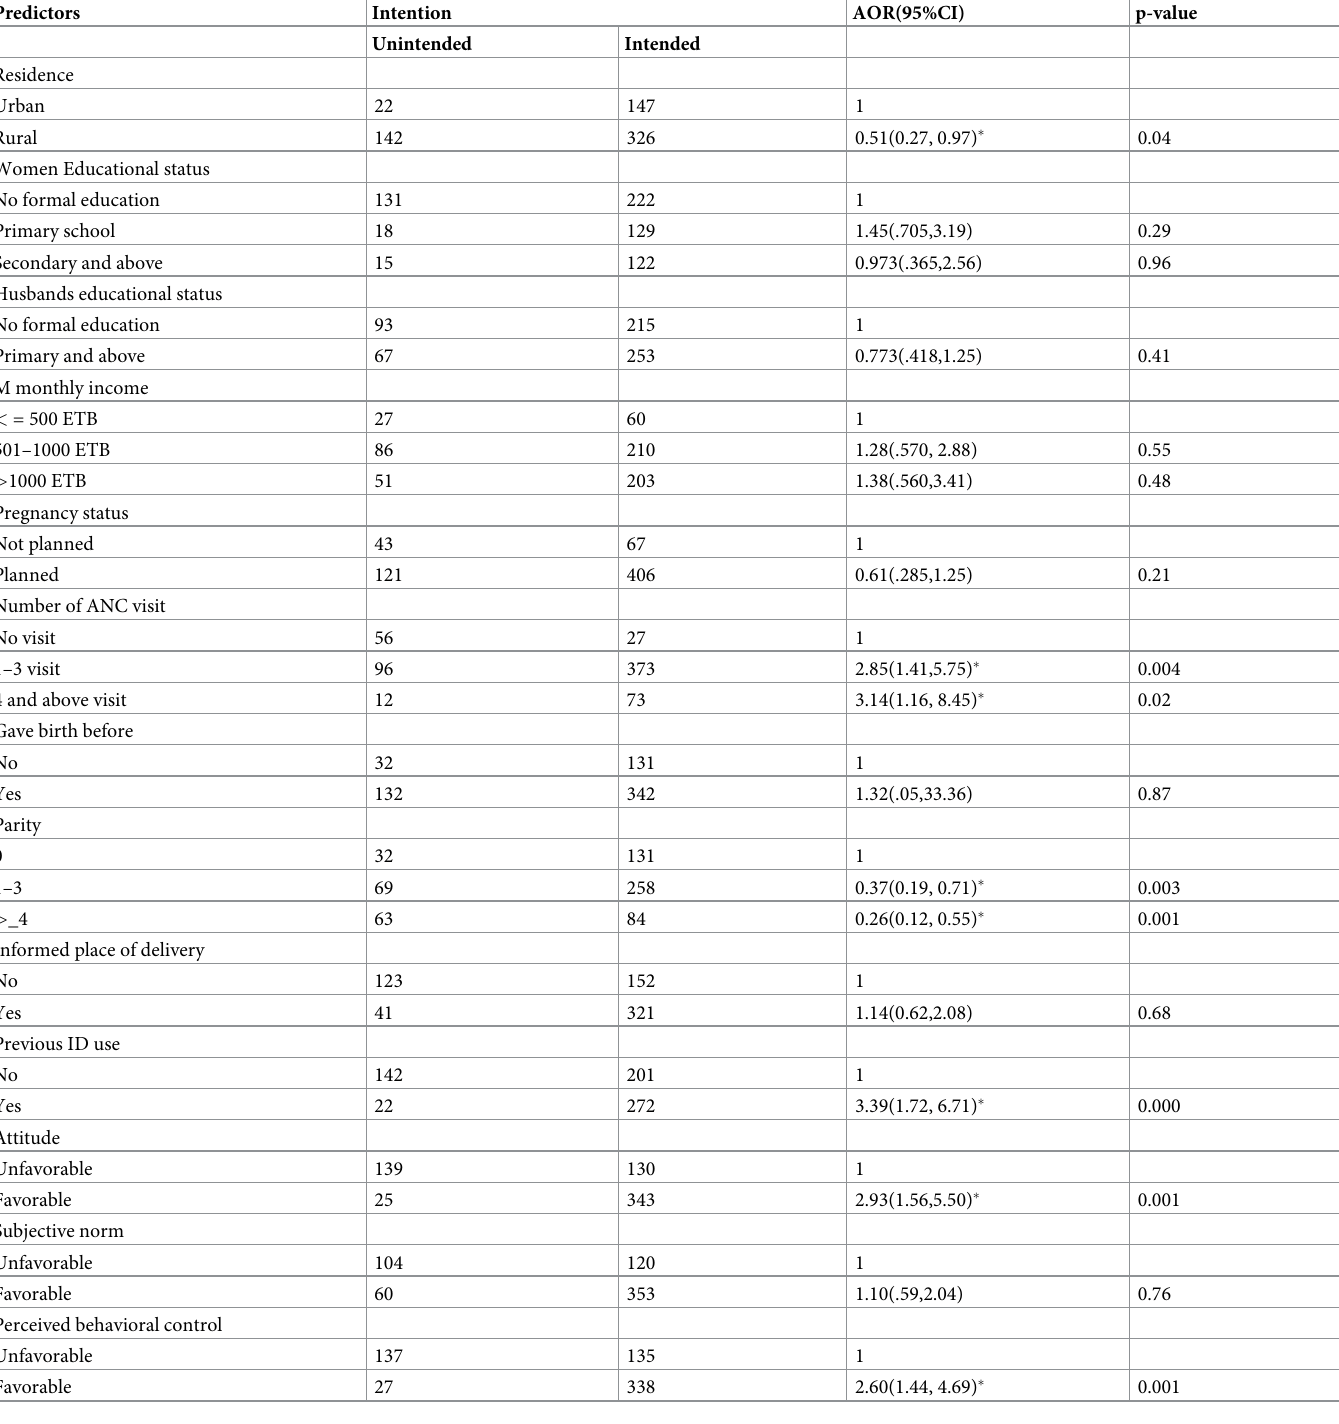
Table 4. Multivariable logistic regression analysis of predictors of intention to use institutional delivery service among pregnant mothers in Yilmana Densa district, may, 2020 (n =